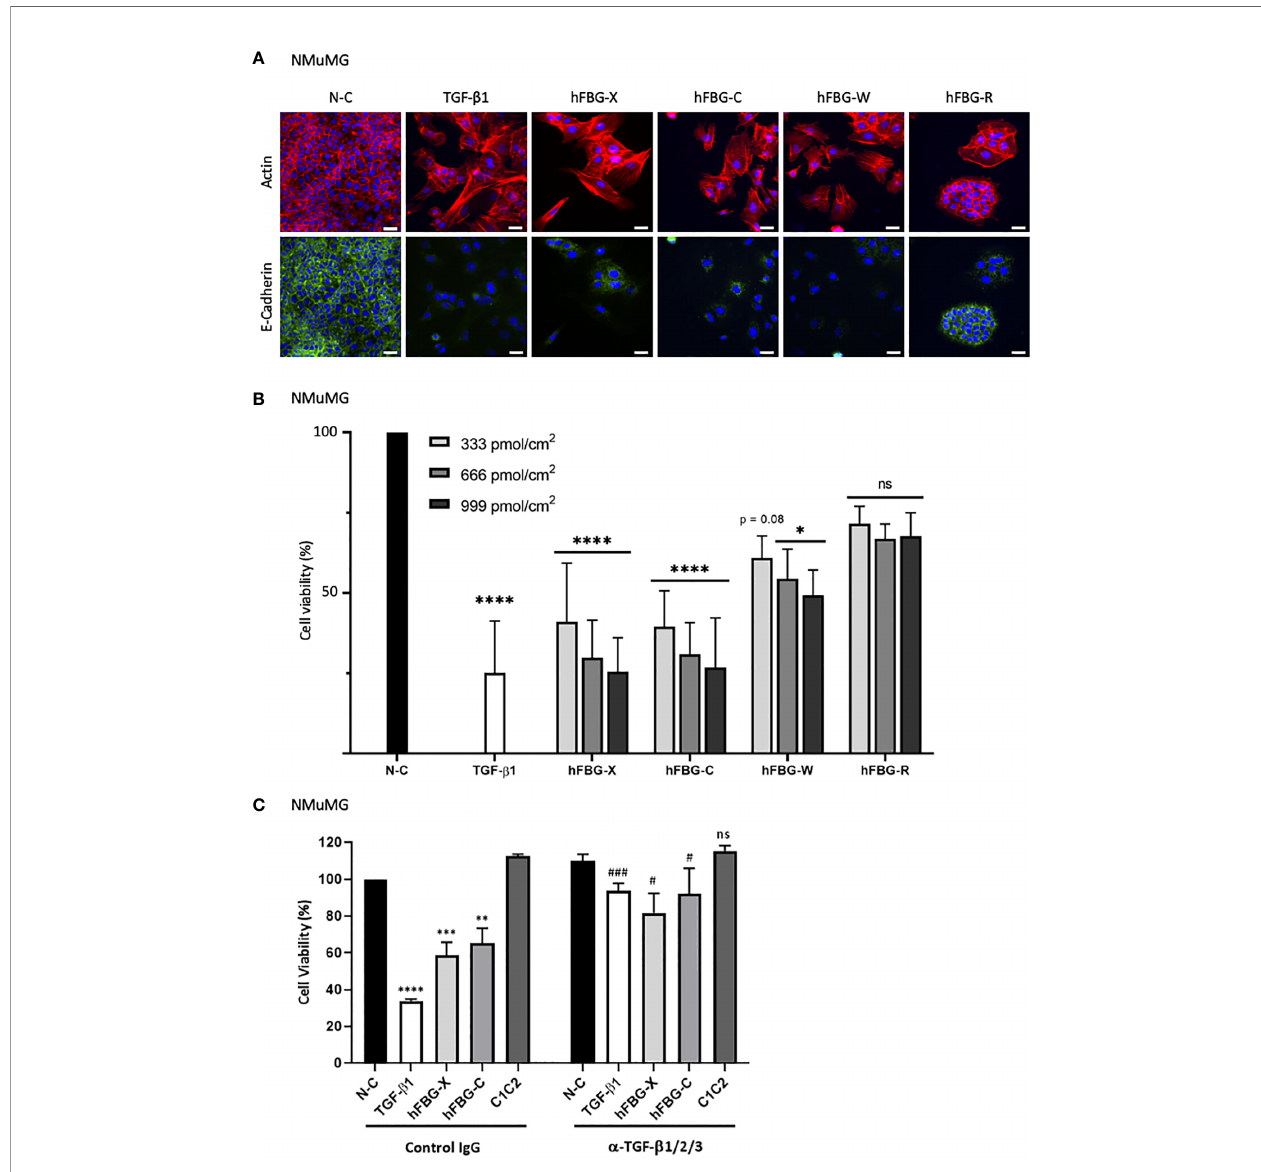
FIGURE 6 | The FBG-like domains of Tenascins trigger EMT and cytostasis in epithelial cells. (A) F-actin direct fl uorescence (red) and E-Cadherin indirect immuno fl uorescence (green) performed on NMuMG cells cultured for 72h onto N-C dishes, dishes coated with 666 pmol/cm 2 FBG-like domains or stimulated with soluble TGF- b 1 (5 ng/mL). Cell nuclei were counterstained with DAPI (blue). Bars, 15 µm. (B) Percentage of cell viability in NMuMG cells cultured for 48h onto N-C dishes, dishes coated with 333, 666 or 999 pmol/cm 2 FBG-like domains, or stimulated with 5 ng/mL TGF- b 1. Error bars are means ± SD from 3 independent experiments. * p < 0.05 compared to N-C condition. **** p < 0.0001 compared to N-C condition. ns, not signi fi cant. (C) Percentage of cell viability in NMuMG cells cultured for 48h onto N-C dishes, dishes coated with 666 pmol/cm 2 FBG-like domains (FBG-X and FBG-C) or CUB1CUB2 protein fragment (C1C2), or stimulated with 5 ng/mL TGF- b 1, in the presence of anti-pan-TGF- b antibody or isotype-matched control IgG (5 m g/mL). Error bars are means ± SD from 3 independent experiments. **, *** and **** respectively correspond to p < 0.01, p < 0.001 and p < 0.0001 compared to N-C condition. # and ### respectively correspond to p < 0.05 and p < 0.001 versus their control IgG-treated counterpart. ns, not signi fi